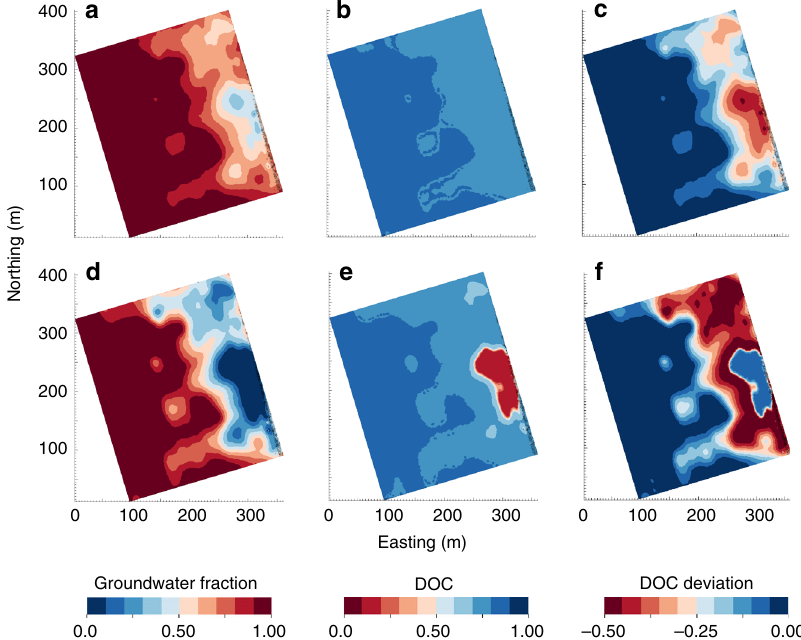
Fig. 5 Spatial projections based on combining ERT estimates of groundwater fraction with aqueous chemistry. Spatial projections were generated across most of the domain that was sampled using groundwater (GW) wells (Fig. 2 and Supplementary Figs. 2,3) 34 . Due to changes in river stage, the HC experienced a broad range of GW – river water mixing conditions during the sampling period 34 . Two temporal snapshots were selected that differed in the degree of mixing. a – c Projections during a point in time with modest river intrusion and higher GW fraction. d – f Projections during a point in time with increased river intrusion and lower GW fraction. a , d Projections of GW fraction where pure GW is indicated by 1 and pure river water (RW) is indicated by 0. b , e Projections of dissolved organic carbon (DOC) concentrations generated by combining a and d with the empirical relationship shown by the gray line in Fig. 3a; DOC is presented as a fraction of RW DOC concentration, as in Fig. 3a. Between b and e there is a relatively small decrease in the GW fraction (i.e., a small increase in the RW fraction, as shown by comparing a with d ). Due to nonlinearity in the relationship between GW fraction and DOC (Fig. 3a), this small decrease in GW fraction led to a large increase in DOC concentrations within the hyporheic corridor (HC). c , f Projections of the DOC mixing model deviations. The projections were generated by combining the spatial projection of GW fraction ( a , d ) with the empirical relationship shown by the gray line in Fig. 3d. The panels show that a large fraction of river-derived DOC was not transported into the broader HC, but that a small decrease in the GW fraction (increase in RW fraction) resulted in signi fi cant quantities of river-derived DOC being transported into the